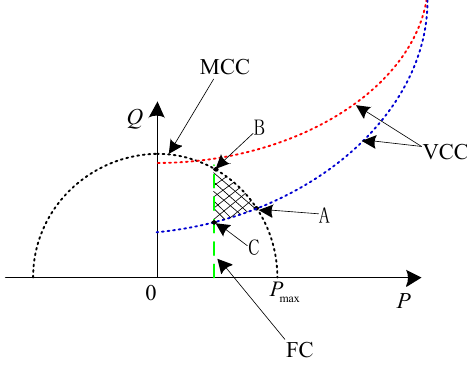
Figure 4. Controllable operation range of the VSC ‐ HVDC inverter.